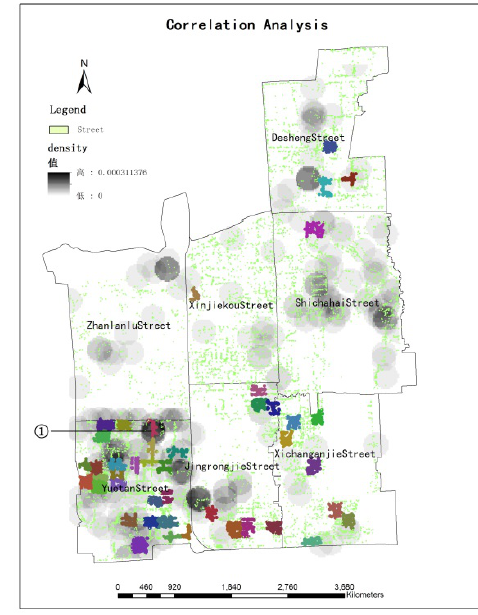
Figure8. Cases management correlation analysis